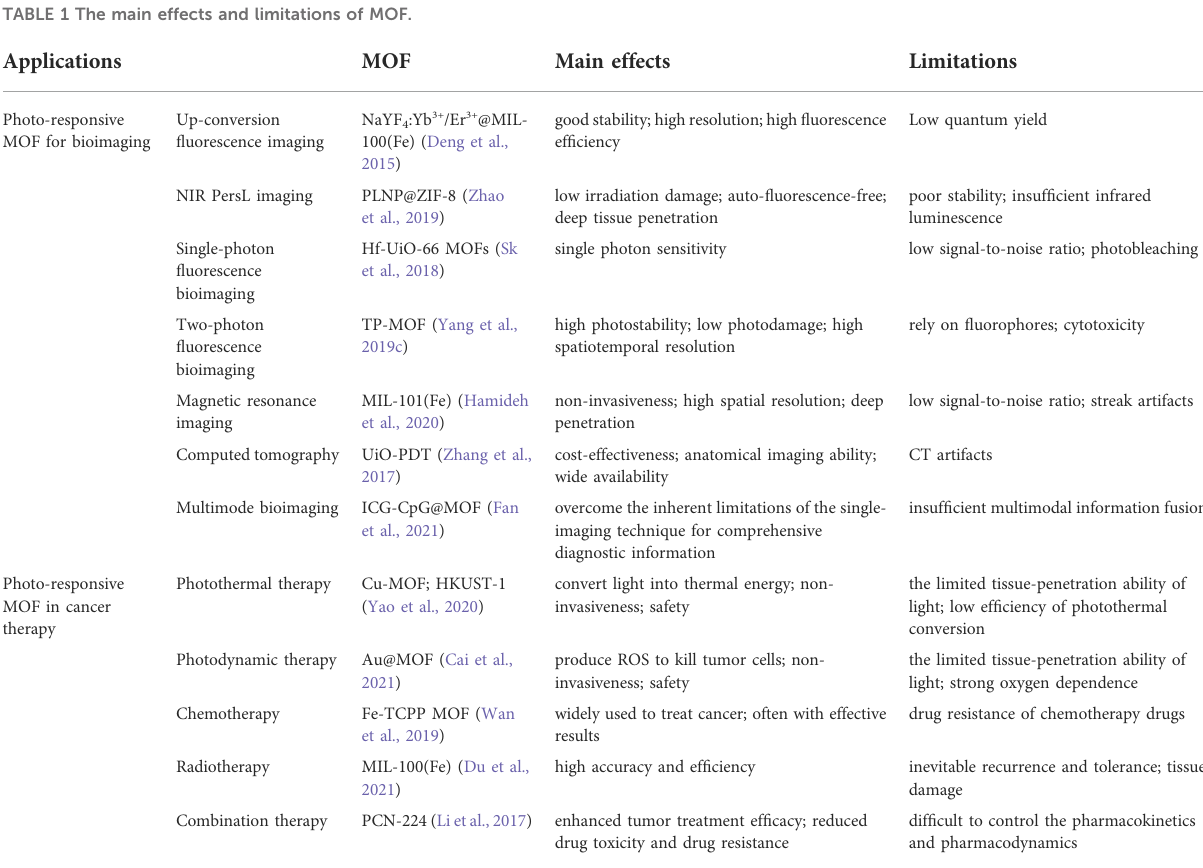
TABLE 1 The main effects and limitations of